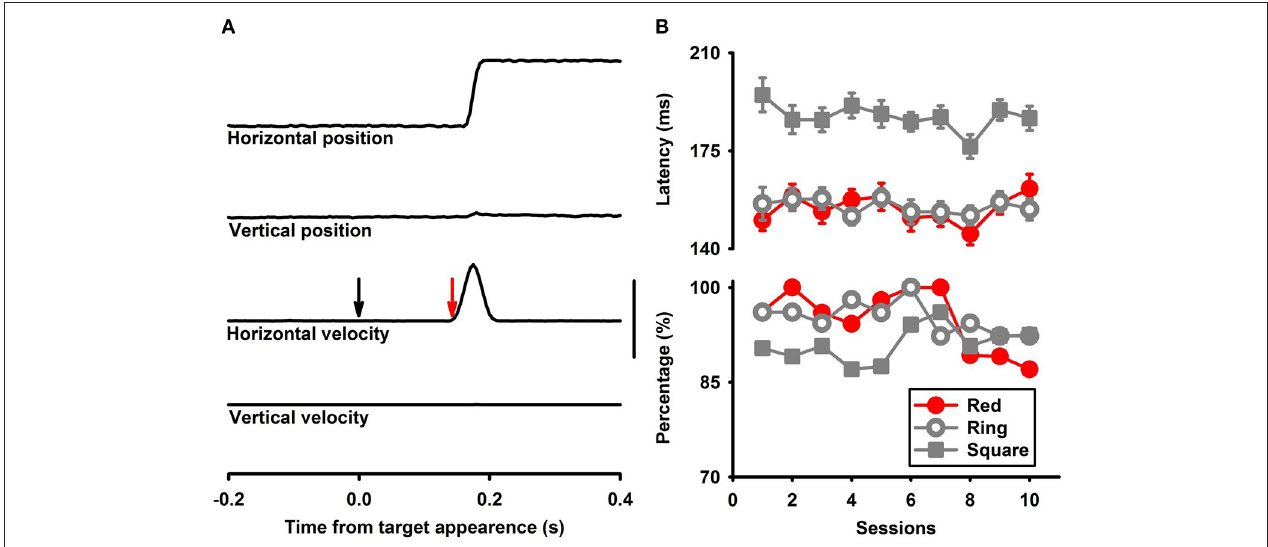
FIGURE 2 | (A) Horizontal and vertical eye position and velocity signals. The black arrow indicates target onset, and the red arrow indicates saccade onset. The vertical bar is 4 ◦ for eye position and 150 ◦ for eye velocity. (B) Representative saccade latencies (upper panel) and accurate rates (lower panel) in multiple sessions for